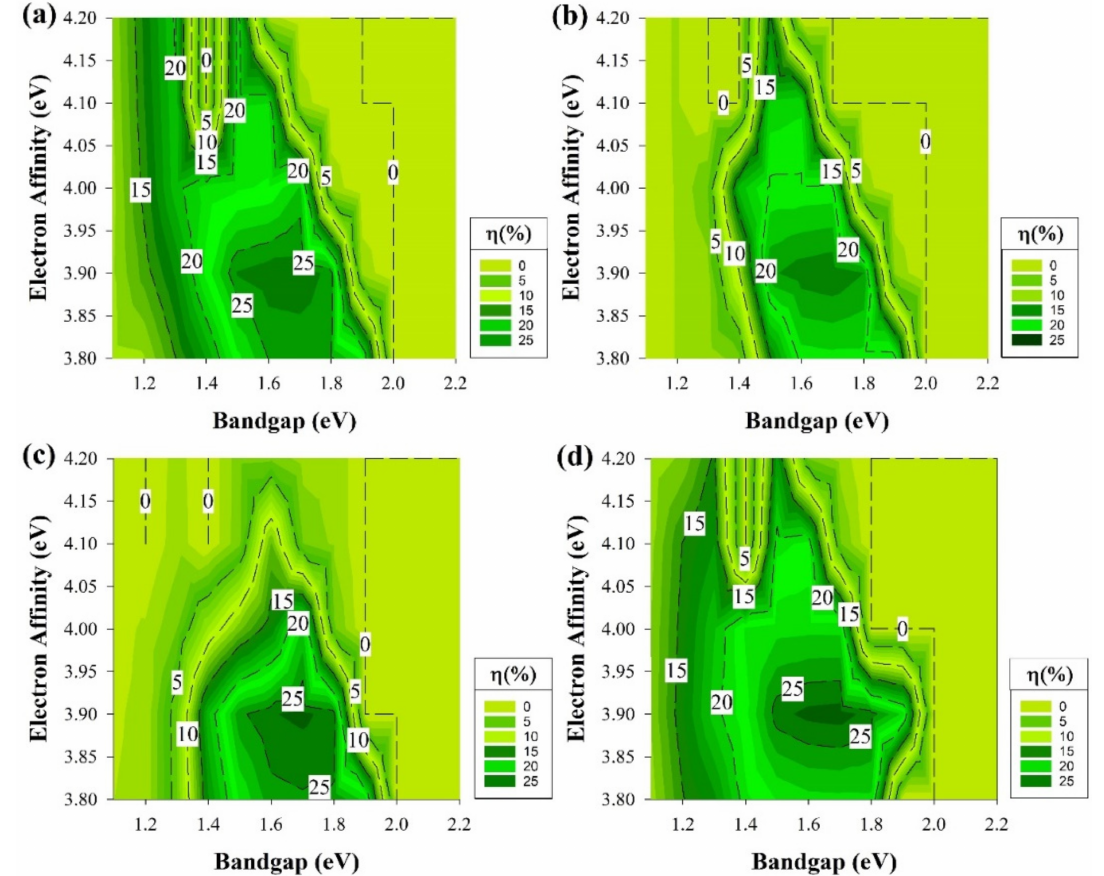
Figure 9. The efficiency of four proposed structures as a function of E g and χ for all passivating and doped layers, including defects at the middle of E g ( a ) Contour graphs of the n-i-p structure with p-type wafer base. ( b ) Contour graphs of the n-i-p structure with n-type wafer base. ( c ) Contour graphs of the p-i-n structure with the p-type wafer. ( d ) Contour graphs of the p-i-n structure with n-type wafer